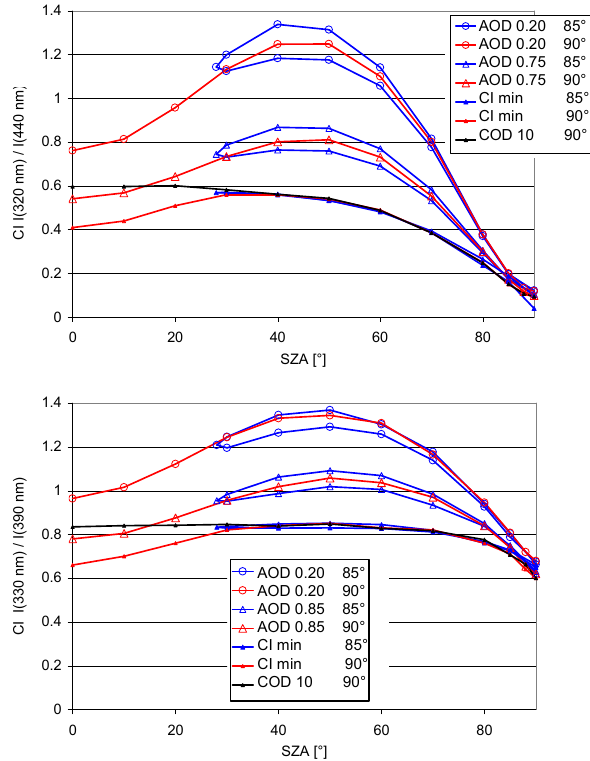
Figure 15. Comparison of simulated CI (top: CI orig: 320nm/440nm; bottom: CI new : 330nm/390nm) for elevation angles of 85 ◦ (blue lines) and 90 ◦ (red lines). The different symbols represent different atmospheric scenarios. The black line represents results for a cloud optical depth of 10.